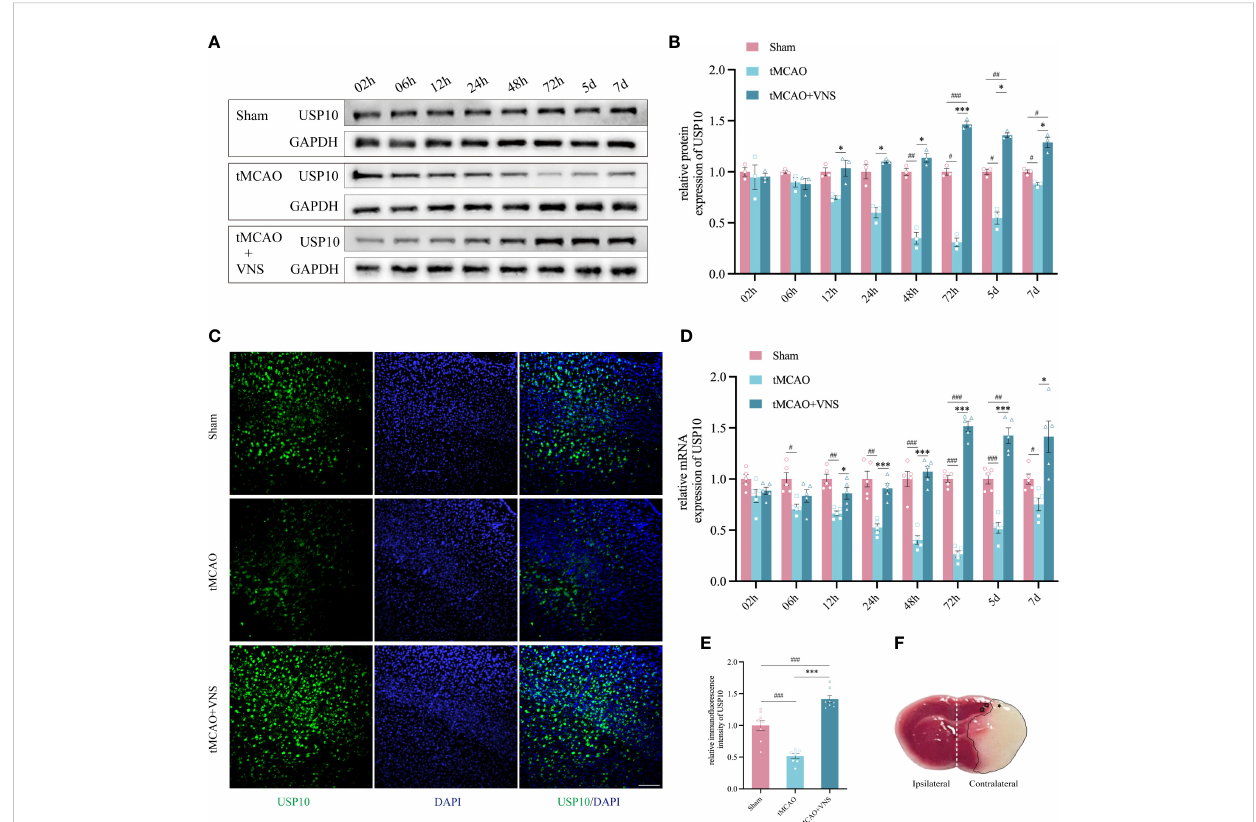
FIGURE 1 VNS enhanced USP10 expression in mice with ischaemic stroke. (A) Western blotting results of USP10 protein levels in each group. (B) Histogram of the USP10 protein expression. n=3. (C) The USP10 expression in the cortex at 72 hr was examined by immuno fl uorescence. Scale bar=100 m m. (D) The RT-qPCR results of USP10 mRNA levels at each time point. n=5. (E) Histogram showed the relative immuno fl uorescence intensity of USP10 (n=8). (F) Relevant areas after tMCAO shown by TTC staining of coronal brain sections: * represents the core area of ischemia; □ represents the ischemic penumbra of the cerebral cortex; the ipsilateral and contralateral cerebral hemispheres are shown with white dashed lines. Data are mean ± SEM. ***P<0.001, and *P<0.05 vs. the Sham group; ###P<0.001, ##P<0.01, and #P<0.05 vs. the tMCAO